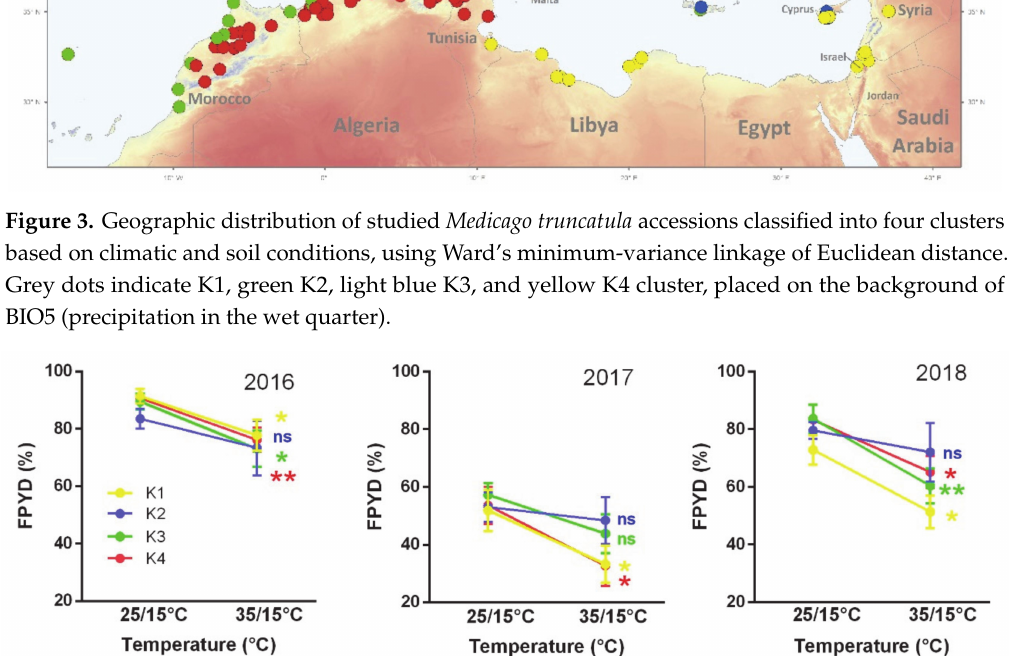
Figure 4. Reaction norms to changes in experimental temperature (25 / 15 ◦ C, 35 / 15 ◦ C treatments) on final PY dormancy of seeds for K1–K4 macro-environmental clusters in three experimental years (2016, 2017, and 2018). Vertical bars indicate ± SE. Asterisk (* p ≤ 0.05 and ** p ≤ 0.01) indicates significant di ff erences between temperatures for each